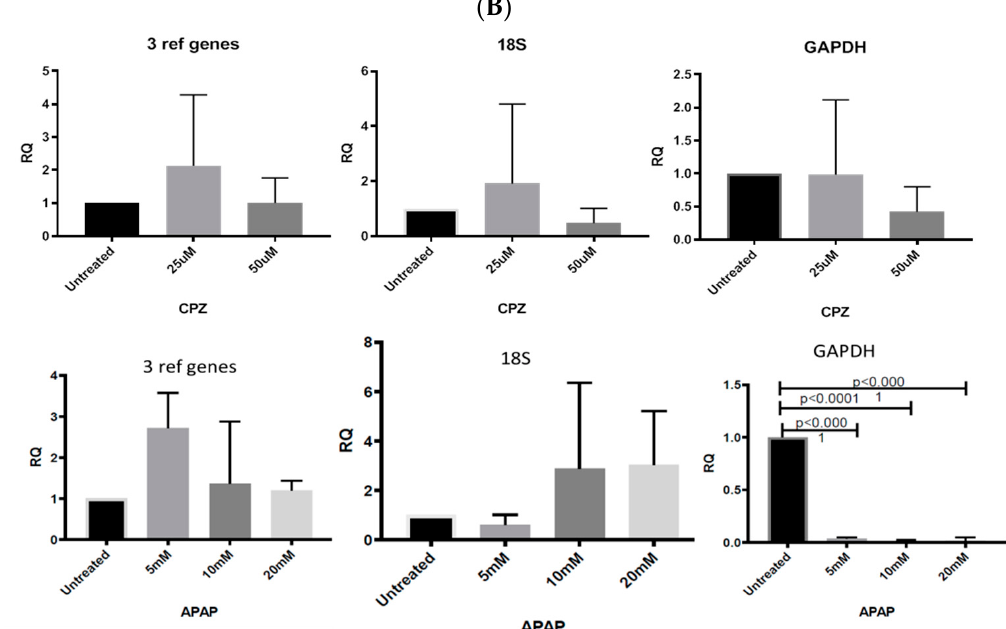
Figure 3. Fold change in the mRNA expression ( ± SD) of ( A ) CYP3A4 and ( B ) HNF4a in HepaRG cells stimulated with di ff erent doses of CPZ or APAP when mRNA expression was normalized using: the geometric mean of the validated reference genes (n = 4), 18S (n = 6), and GAPDH (n = 5). Fold change in mRNA expression is relative to HepaRG untreated cells. The application of single reference genes for data normalization show significant transcription discrepancies in comparison with data normalized with validated reference